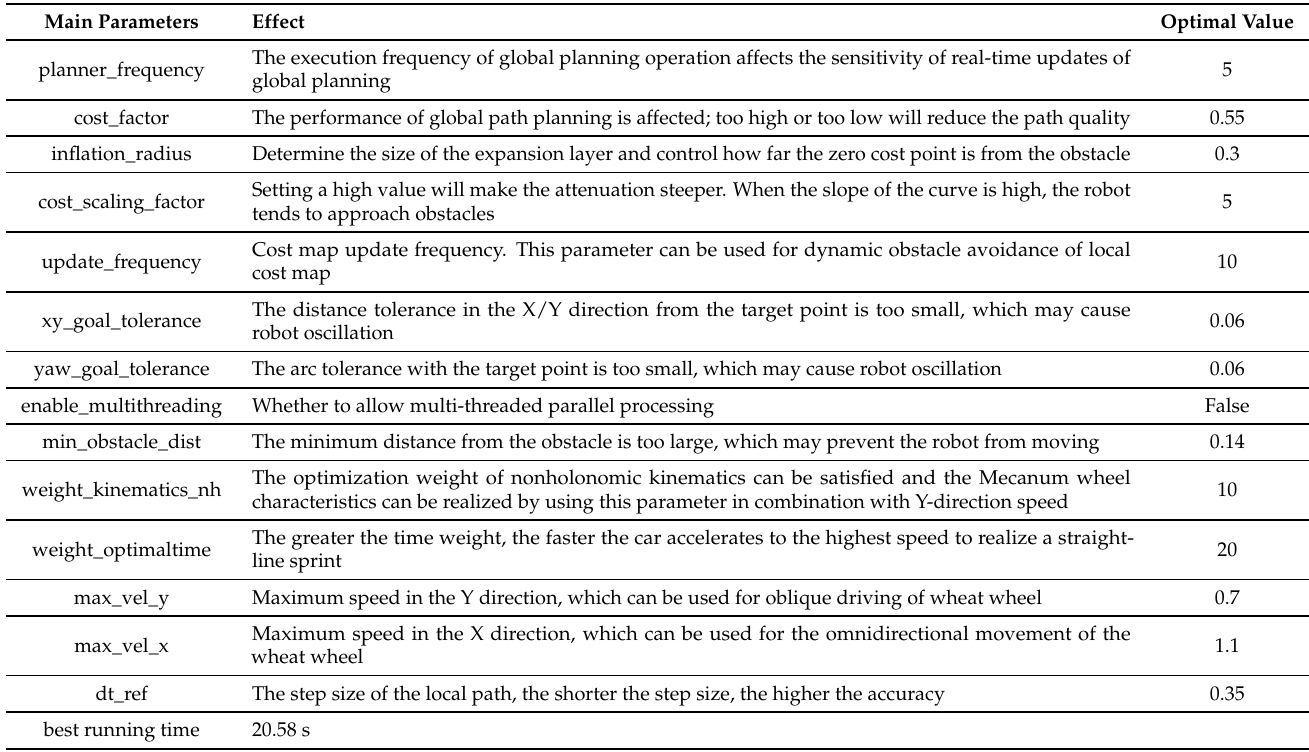
Table 4. Parameter results of the TEB algorithm